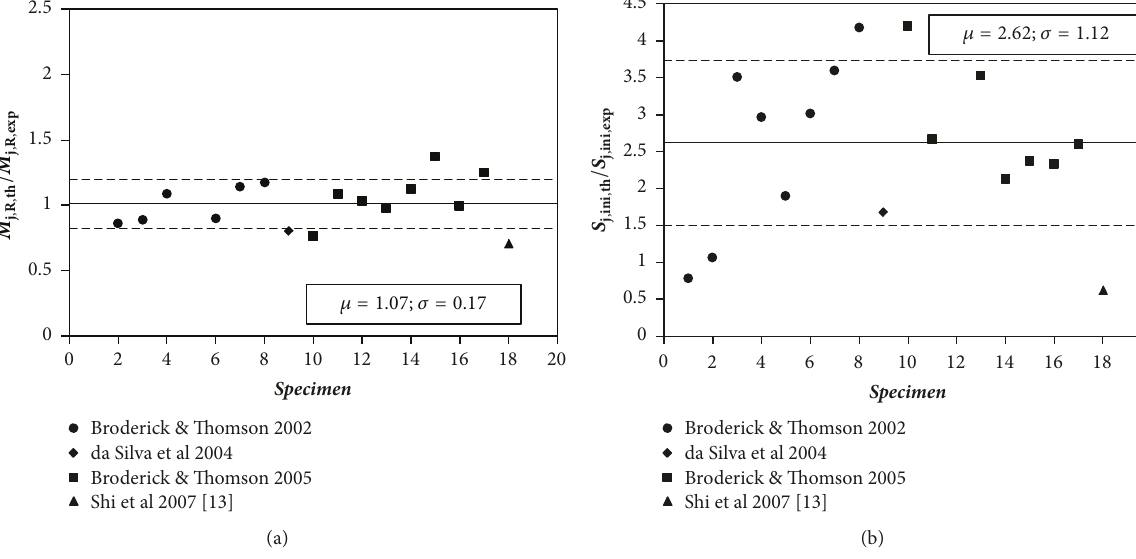
Figure 3: Ratios of theoretical to experimental moment resistance (a) and initial stiffness (b) for flush end-plate joints [7].